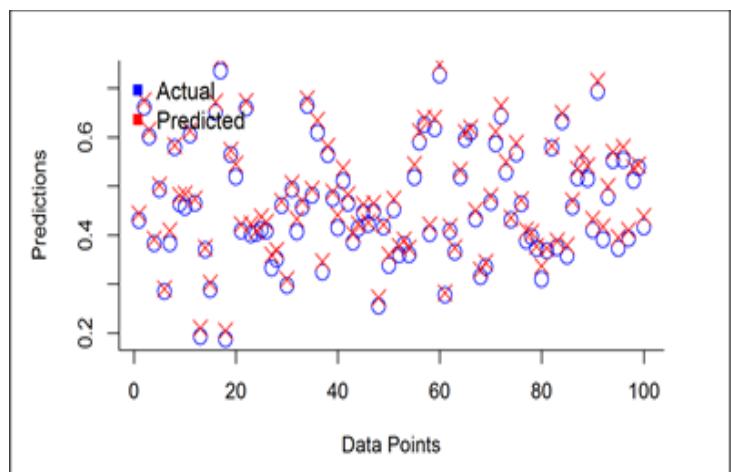
Fig. 10. The prediction results for T1FLS.